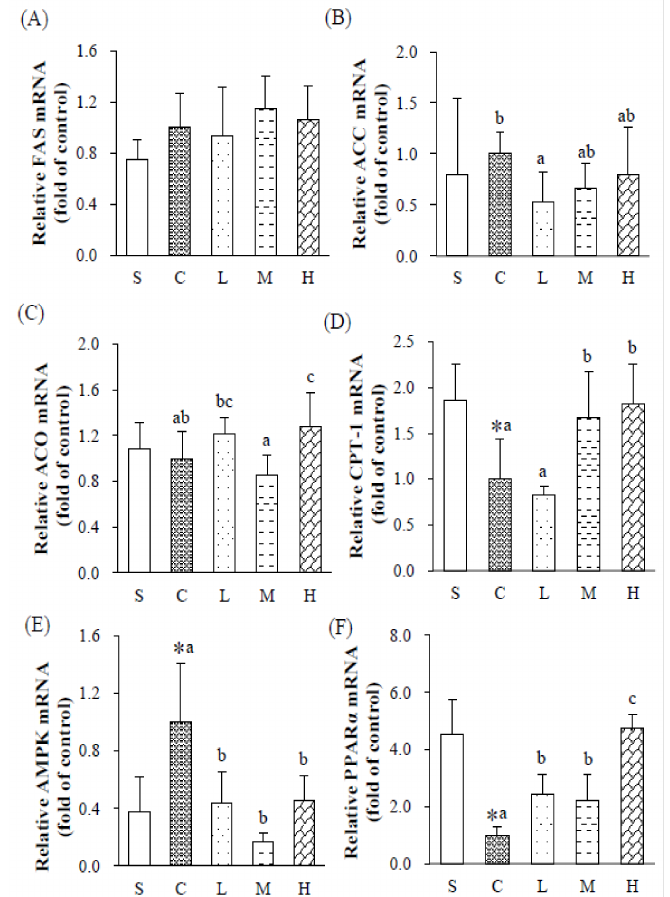
Figure 1. Hepatic mRNA expressions after 8 weeks of a dietary intervention. Relative mRNA expressions of ( A ) acetyl CoA carboxylase (ACC), ( B ) acetyl CoA oxidase (ACO), ( C ) fatty acid synthase (FAS), ( D ) carnitine palmitoyl transferase (CPT)-1, ( E ) 5 (cid:48) AMP-activated protein kinase (AMPK) and ( F ) peroxisome proliferator-activated receptor alpha (PPAR α ). Results are presented as the mean ± standard deviation. * p < 0.05 vs. S; a,b p < 0.05 between different superscripts. S, sham-operated group; C, control group; L, low-dosage group; M, medium-dosage group; H, high-dosage